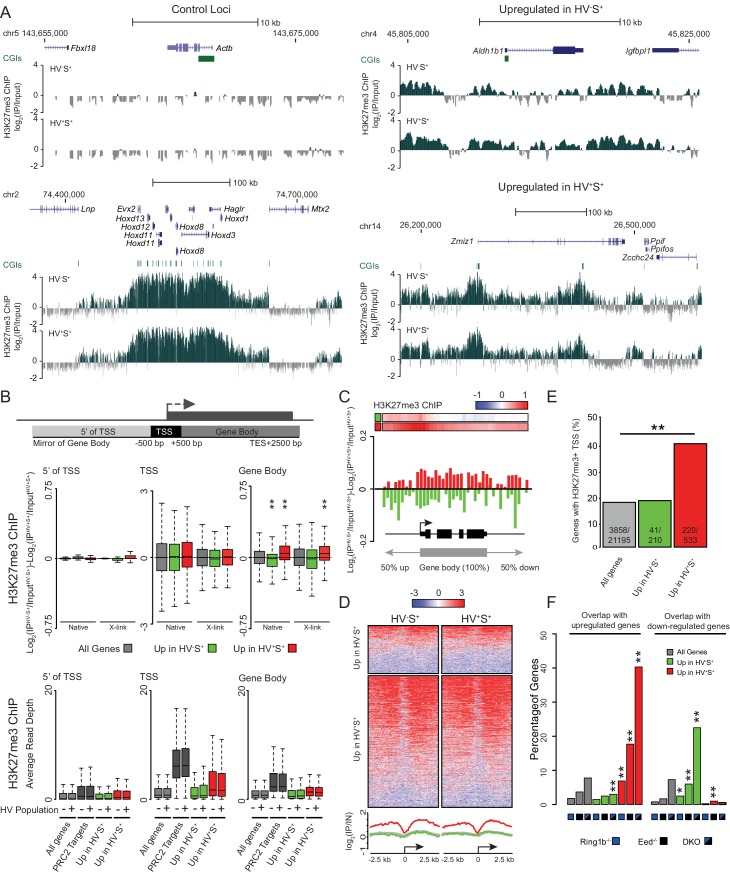
PrEn priming genes are enriched for polycomb targets.(A) Example H3K27me3 ChIP-seq profiles (log2(IP/Input)) for Actb and Hoxd (Control Loci), Aldh1b1 (Upregulated in HV-S+) and Zmiz1 (Upregulated in HV+S+). Coordinates given are for the mm9 genome build. (B) Schematic representation of the stratification used to bin H3K27me3 signal with respect to genes (upper panel) and boxplots showing the ratio and average read depths (middle and lower panels respectively) of H3K27me3 ChIP-seq signal. The ratios represent the comparison of H3K27me3 ChIP-seq signal between the HV-S+ and HV+S+ ESC populations for both native and formaldehyde cross-linked ChIP (indicated as ‘native’ and ‘X-link’ respectively; the data is presented as in Figure 1G). Genes were defined as ‘PRC2 Targets’ if they were enriched for H3K27me3 at their TSS (± 100 bp) and were also upregulated in cells deficient for the PRC2 component EED (Leeb et al., 2010). Two-sample permutation tests (oneway test) were used to compare the H3K27me3 ChIP-seq signal at priming vs all genes. P values of < 0.01 are indicated** (all indicated p values are < 2.2 × 10−16). (C) H3K27me3 ratios (log2(IPHV-S+/InputHV-S+)-log2(IPHV+S+/InputHV+S+)) between the HV-S+ and HV+S+ populations presented as for Figure 1F. (D) TSS (± 2.5 kb) heatmaps and summary plots of H3K27me3 signal (log2(IP/Input)) for genes with differential expression between the HV-S+ and HV+S+ ESC populations. (E) Barplot representing the percentage of genes that are enriched for H3K27me3 within 100 bp of their TSS. Significance enrichment versus all genes was tested using a Fisher’s test and ** indicates a p value of < 0.01 (actual value of 3.4 × 10–36). (F) Barplots depicting the proportion of priming-genes that are up- or down-regulated in Ring1b-/-, Eed-/- or Ring1b-/-/Eed-/- double knockout ESCs (blue, black and blue/black labelled bars, respectively). Significant enrichment or depletion relative to all genes was assessed using a Fisher’s exact test and significant enrichment or depletion for each comparison is indicated (*0.05 > p ≥ 0.01 and **p < 0.01). Significant p values indicated*/** are 7.5 × 10–3, 3.51 × 10–11, 1.08 × 10–33, 7.49 × 10–89, 2 × 10–2, 2 × 10–3, 1.34 × 10–11 and 2.99 × 10–13 (left to right).